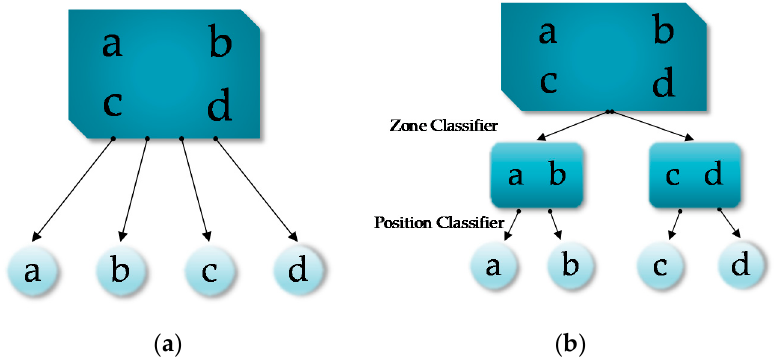
Figure 1. Two types of classification: ( a ) flat classification; ( b ) hierarchical classification.